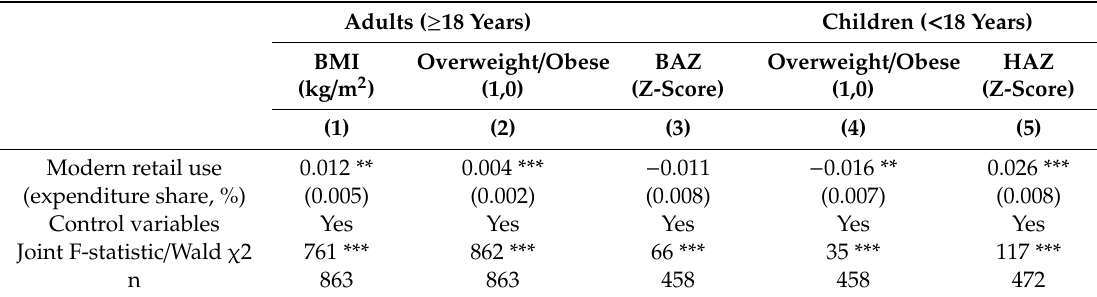
Table 4. E ff ects of using modern retailers on nutrition